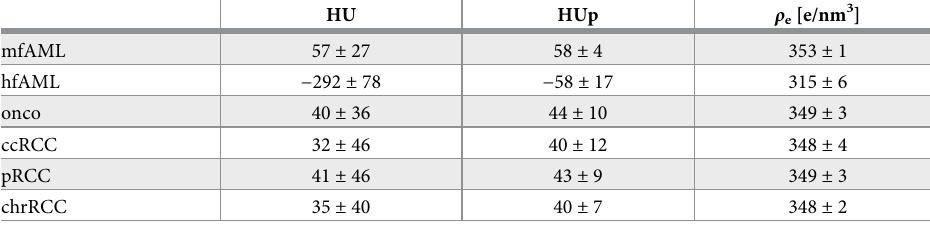
Table 1. Mean and standard deviation (mean ± std) of the conventional CT number in HU, the phase-contrast CT number in HUp and the electron density ρ e for conventional GBAC-CT (HU) and GBPC-CT (HUp and electron density) slices for different types of renal lesions. HU: Hounsfield units, HUp: Hounsfield units phase, mfAML: min- imal-fat angiomyolipoma, hfAML: high-fat angiomyolipoma, onco: oncocytoma, ccRCC: clear cell renal cell